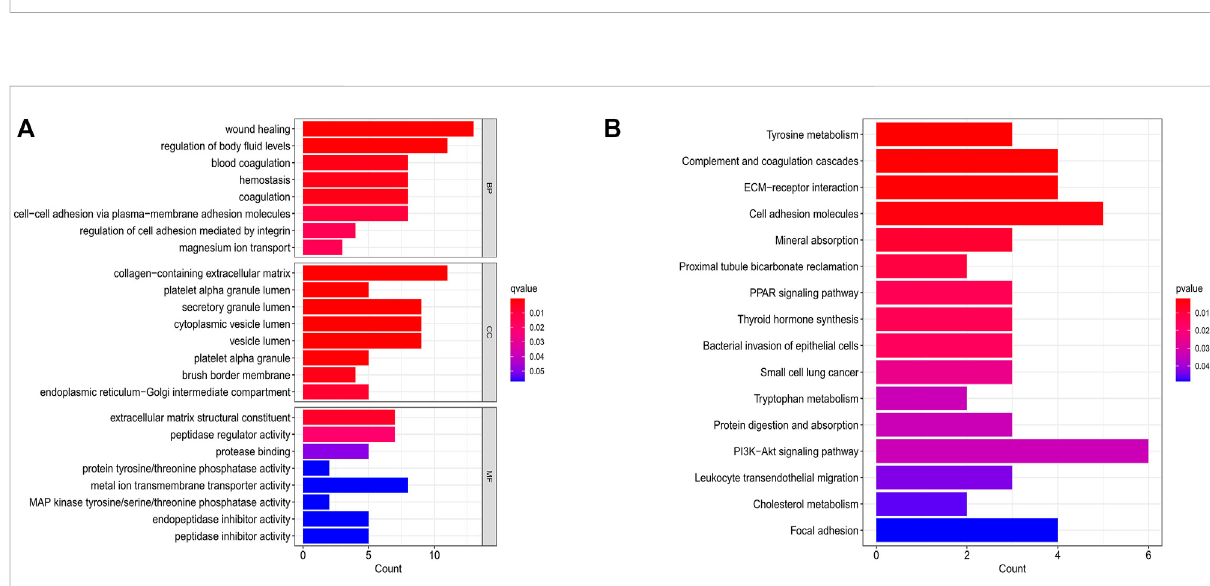
FIGURE 2 Heatmap and volcano plot of DEGs. (A) The heatmap of differential expression analysis result. The colors of the heatmap, from red to blue, indicatehightolowexpressionofgenesinnormalandPTCsamples.Ontheupperpartoftheheatmap,thebluebandrepresentsnormalsamplesand the red band stands for PTC samples. (B) The volcano plot of DEGs. The X -axis is logFC, and the Y -axis is – log10 (adj. p value). The high-expression genes ’ adj. p value < 0.05andlogFC > 1.5arelocatedonthetop-right.Thedown-regulatedgenes ’ adj. p value < 0.05andlogFC < -1.5arelocated on the top-left. In addition, the black dots indicate the remaining stable genes.